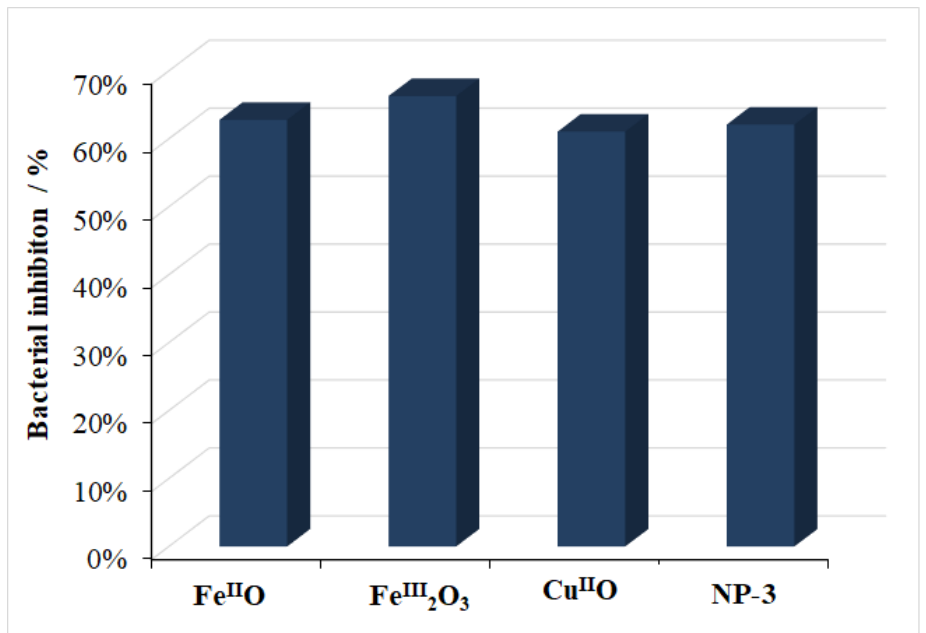
Figure 15. Comparison of bacterial inhibition percentage of Fe II O, Fe III 2 O 3 , Cu II O, and doped NP-3 (Cu II 0.4 Fe II 0.6 Fe III 2 O 4 ).